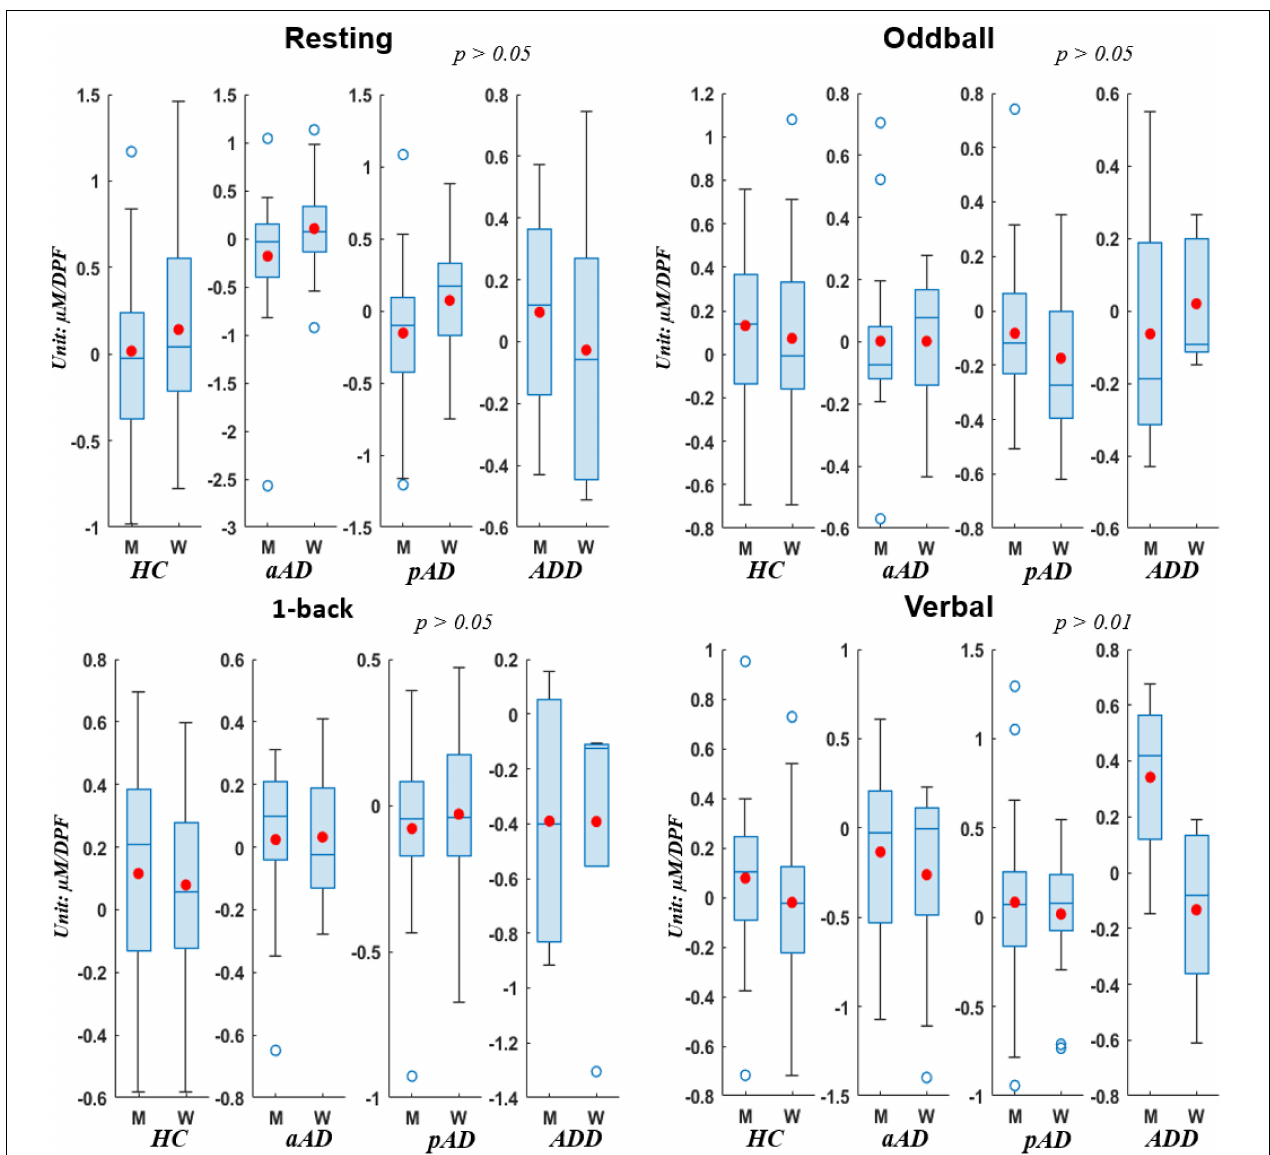
FIGURE 5 | Box charts of HbO concentrations acquired by Men (M) and Women (W) of four subject groups under four